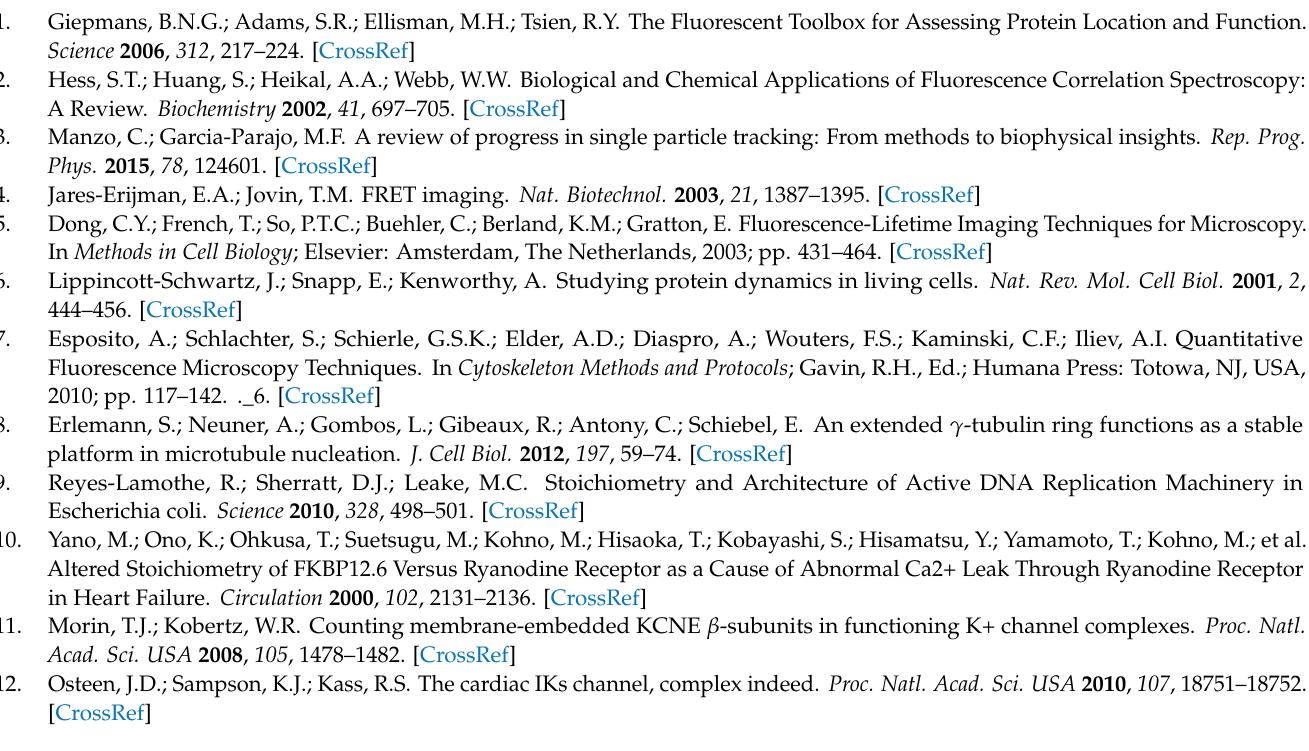
Figure S2: Second step of background correction; Figure S3: Histogram of the time spent in one of the dark states for single Alexa Fluor 647 molecules attached to DNA origami structures; Figure S4: Histogram of excess relative variances calculated from background-corrected fluorescence traces of single Alexa 647 molecules attached to a DNA origami structure; Figure S5: Average and variance of 255 background-corrected time traces of single Alexa 647 molecules attached to a DNA origami structure; Figure S6: Determination of Y 1 and ¯ Y blink for the simplified estimator from a fluorescence trace Y t